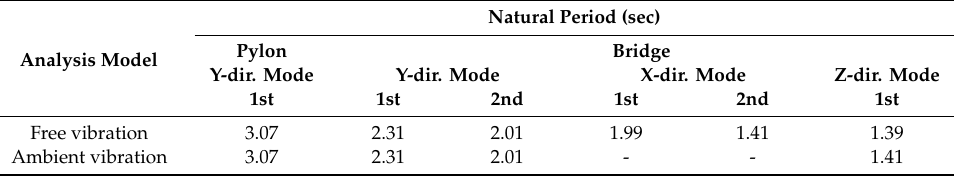
Table 3. Natural periods of testing bridge.